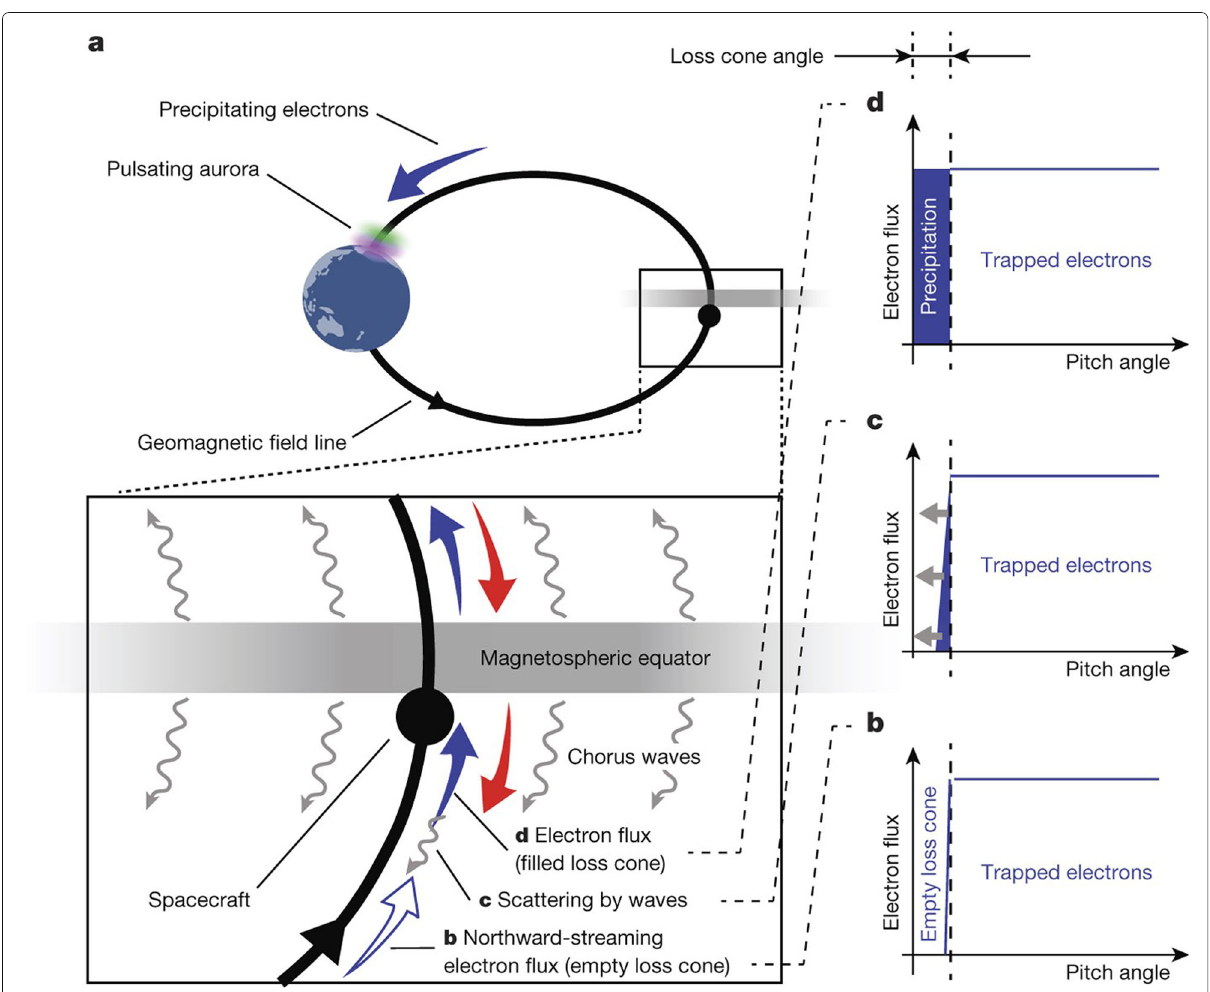
Fig. 15 Interaction of electrons with Chorus waves leading to their precipitation Figure reproduced from Kasahara et al. (2018)